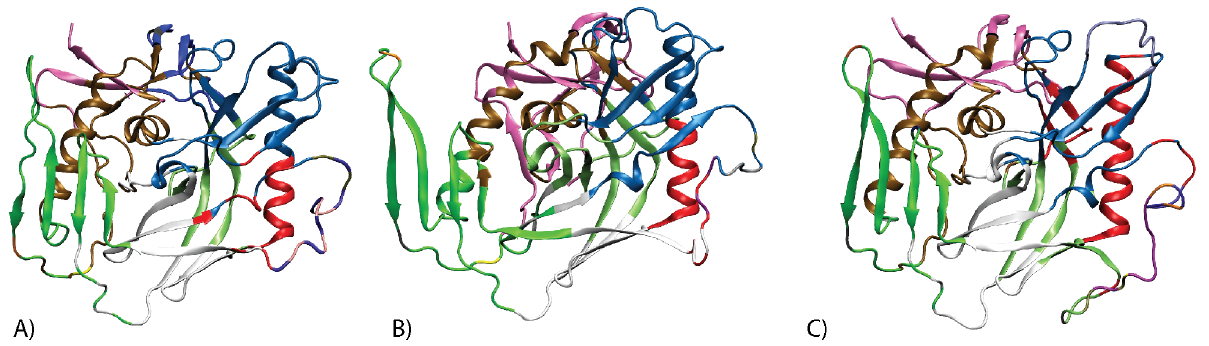
Figure 5. The modules or communities in the network for (A) YU2, (B) HXB2, and (C) CAP210 networks. The color represents the community that the residue belongs to (bridging sheet – green, ab -bundle – brown, b -sandwich – magenta, parts of 6-stranded barrel – blue, V4 and a 2 helix – red, 6- stranded barrel – white, interface of the two barrels in outer domain – lime).